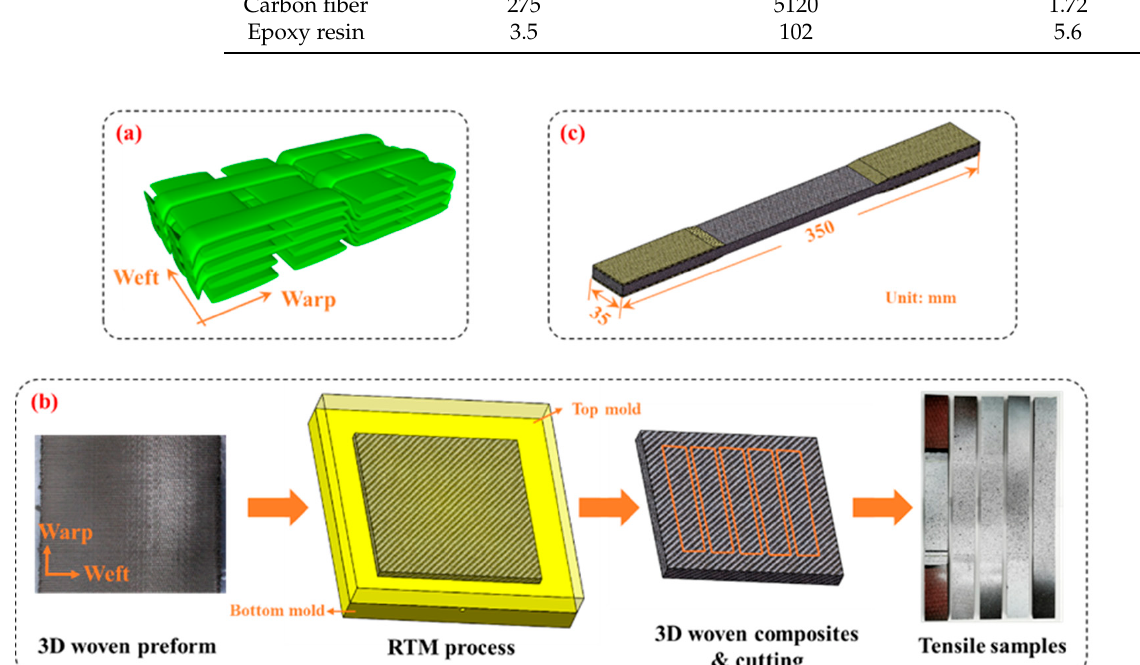
Figure 1. The 3D woven composites and samples: ( a ) 3D woven architecture, ( b ) the tensile sample manufacturing process and ( c ) the geometrical sizes of the tensile sample.